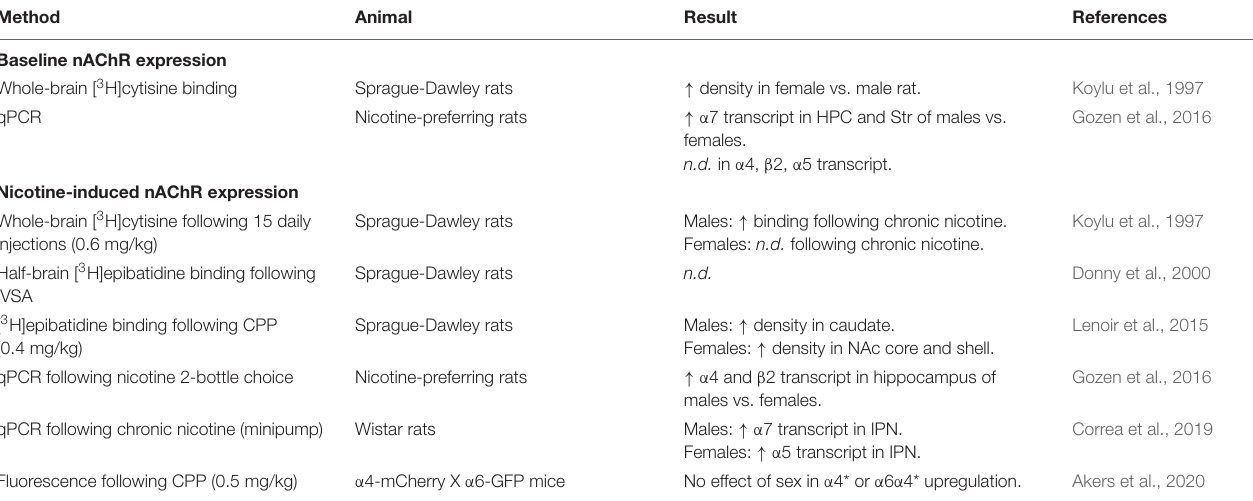
TABLE 2 | Summary of studies on brain nAChR expression in male and female